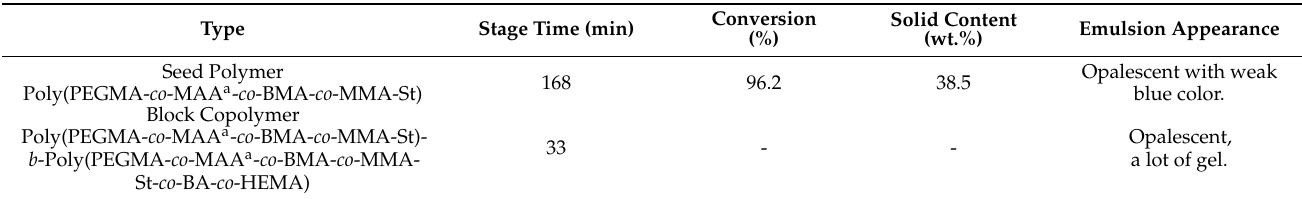
Figure 7. TEM micrograph of ( a ) the seed polymer and ( b ) the block copolymer described in Table 12. We investigated whether the random copolymer can be used as macro-chain transfer agent or macro-emulsifier in the chain extension reaction when BA and HEMA were added in at second polymerization stage. As shown in Table 13, the emulsion of the random copolymer poly (PEGMA- co -MAA a - co -BMA- co -MMA-St) was stable and milky white with a weak blue color. When the monomer mixture comprising BA and HEMA was added at the second polymerization stage, the emulsion was not stable, and a lot of coagulation existed after 33 min of reaction time. The pH value of the withdrawn sample ranged between 6.5 and 7, and there were no nonionic MAA monomers that participated in random copolymerization with HEMA, thereby restraining the formation of an interpolymer complex. Crosslinking caused by transesterification among the pendent hydroxyl groups can lead to crosslinked polymers [23,24], and these crosslinked polymers may lead to instability of the emulsion. Thus, the emulsion was not stable, and a large amount of gel existed after 33 min. The instability of the emulsion in the chain extension reaction period indicated that HEMA could not be copolymerized fluently in the chain extension reaction of this emulsion polymerization system. Table 13. Chain extension reaction with BA and HEMA.